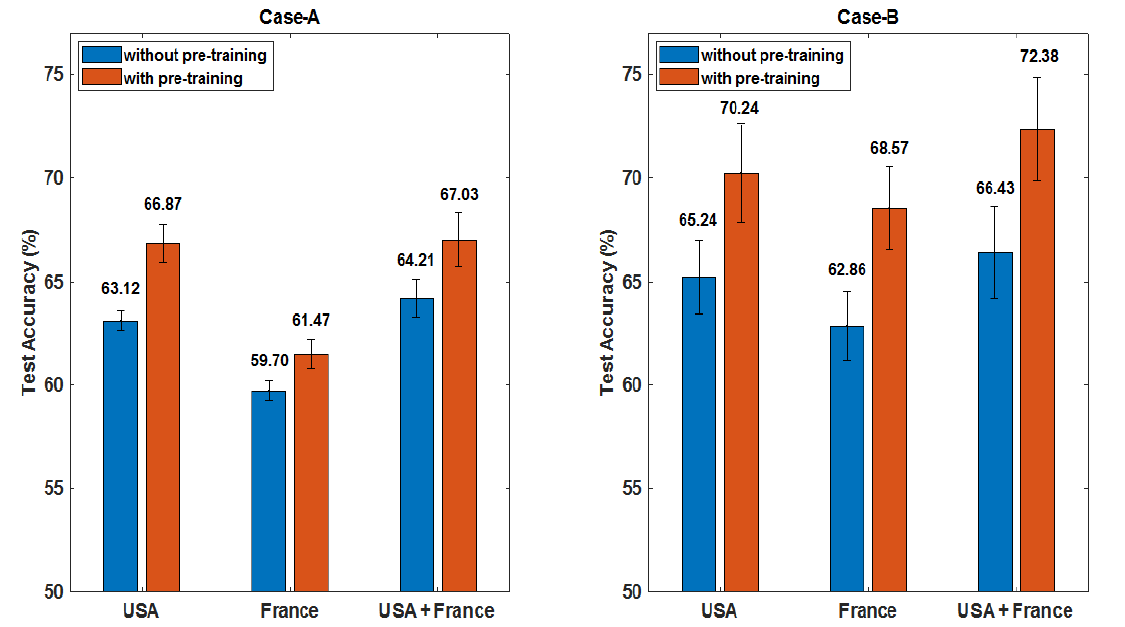
Figure 6. Comparison of test performance on individual dataset and on combined dataset (without domain mapping). Further the effect of using GAN augmented data for pre-training is also examined (red bars) as compared with those without using GAN augmented data (blue bars). Left: Case-A: pre-training effect on classification of 1p/19q codeletion/non-codeletion has shown improvement by about 3%. Right: Case-B: pre-training effect on classification of IDH mutation/wild-type has shown improvement by about